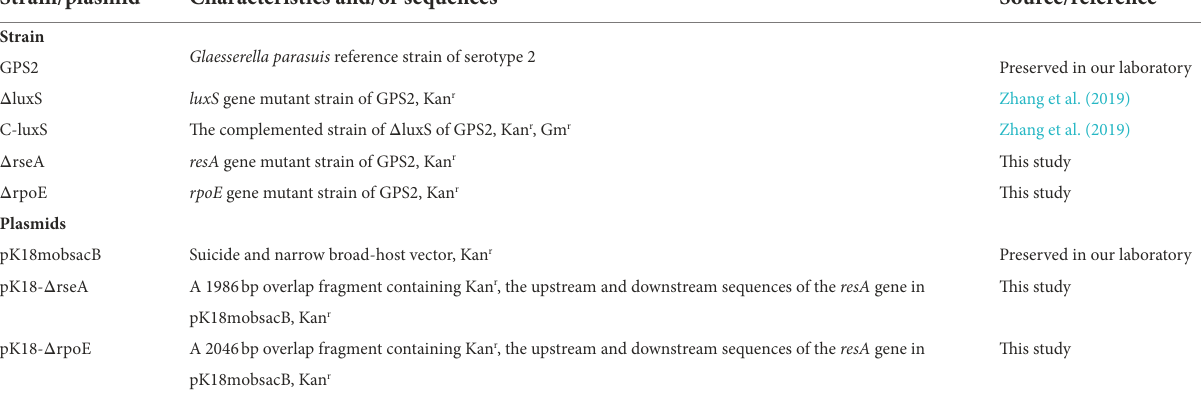
TABLE 1 Characteristics of bacterial strains and plasmids used in this